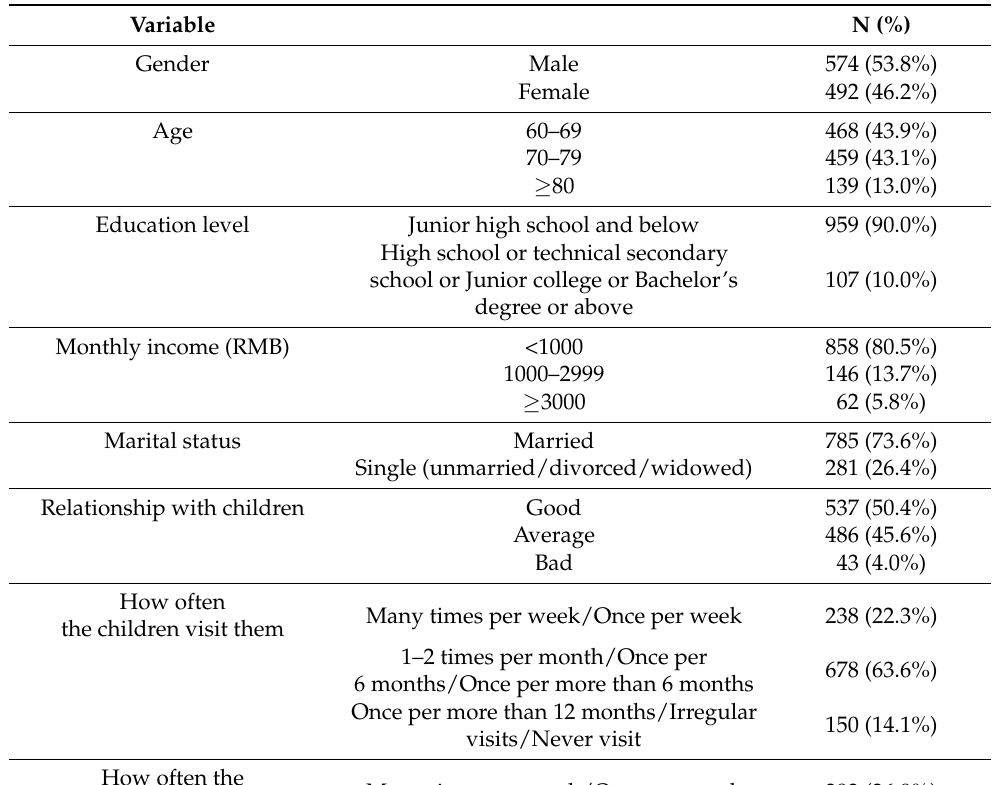
Table 1. General characteristics (N =